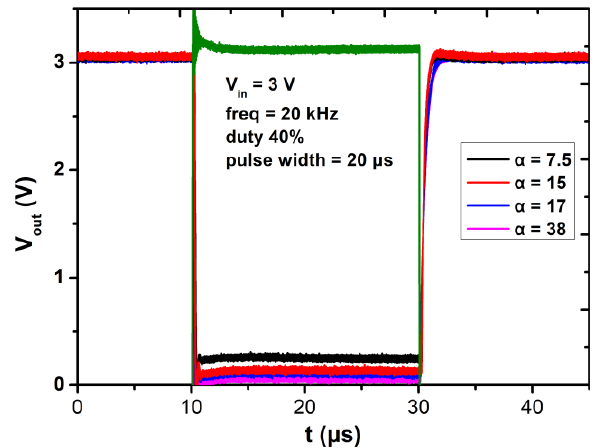
Figure 9. The transient output waveforms with input of 20 kHz square wave from 0 to 3 V with different α .